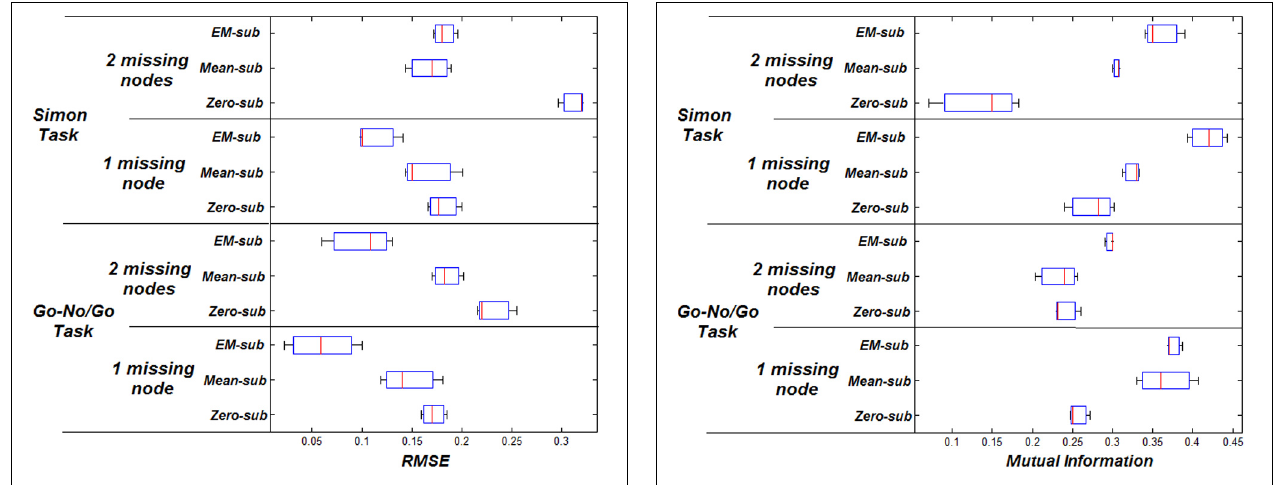
FIGURE 4 | MI between predicted and measured response for both